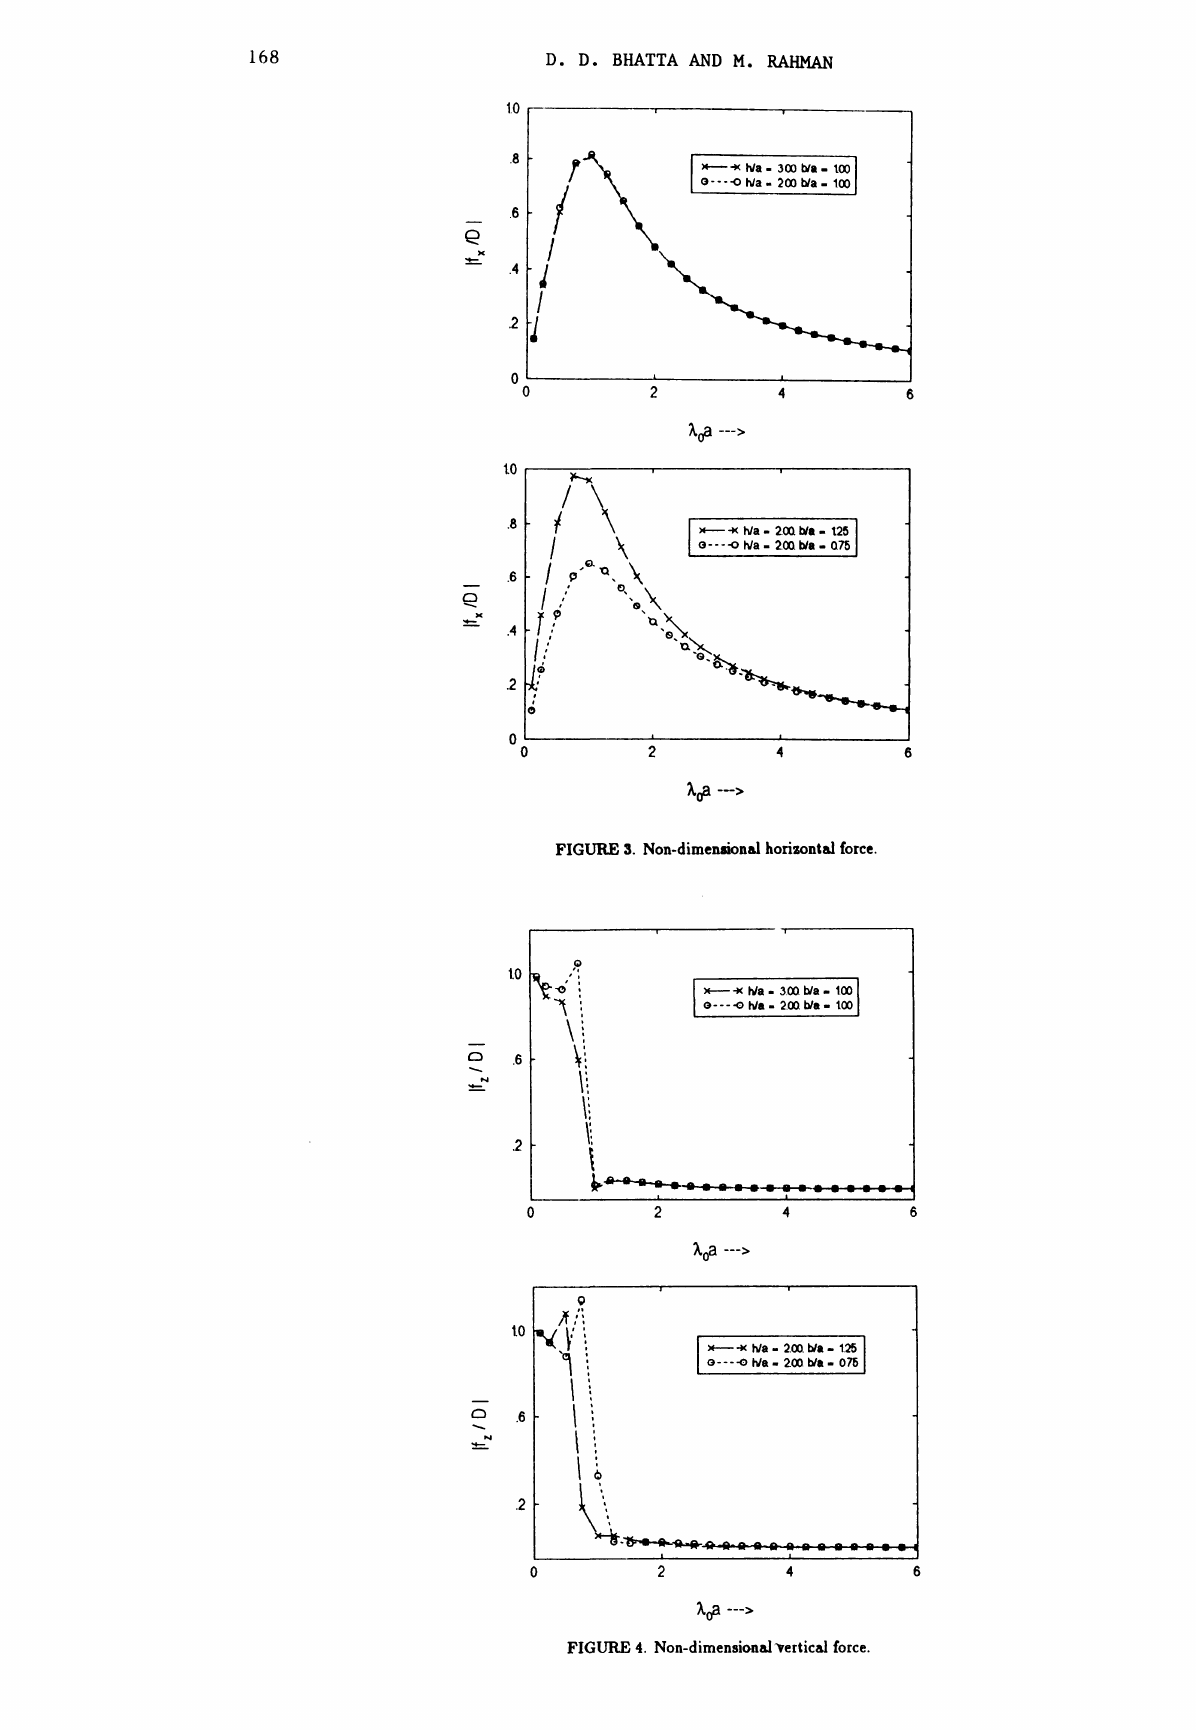
FIGURE 3. Non-dimensional horizontal force.